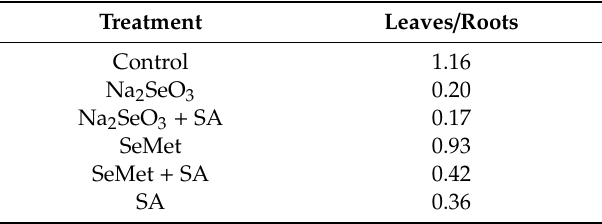
Table 4. The leaf to root ratio of total Se content. Treatment Leaves /